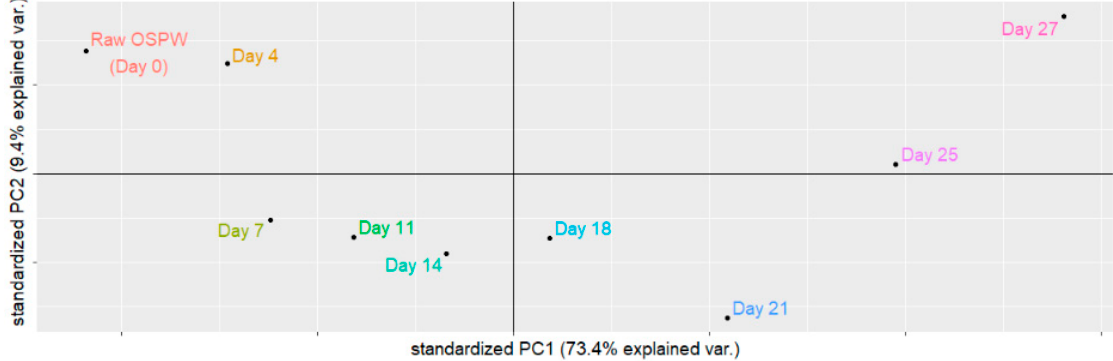
Figure 1. Principal component analysis (PCA) plot of negative-ion electrospray ionization (ESI) high-resolution Orbitrap-MS showing the variance in the degradation of naphthenic acid fraction compounds (NAFCs) over time in the constructed wetland treatment system (CWTS).